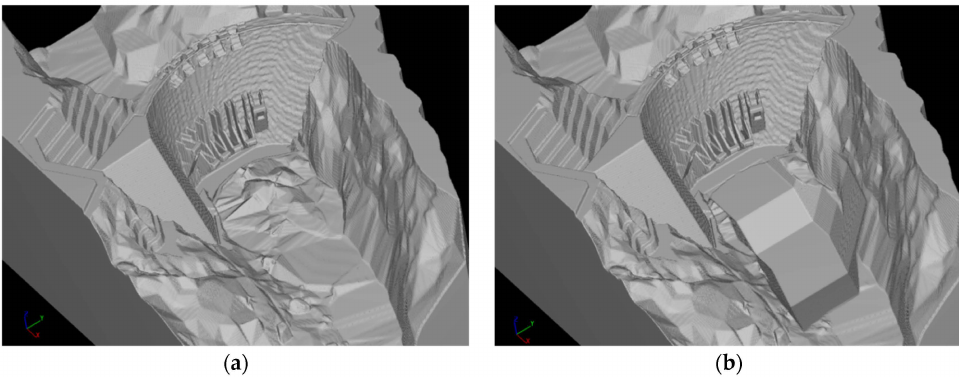
Figure 13. Pre-excavated basin. ( a ) Initial condition; ( b ) geometry